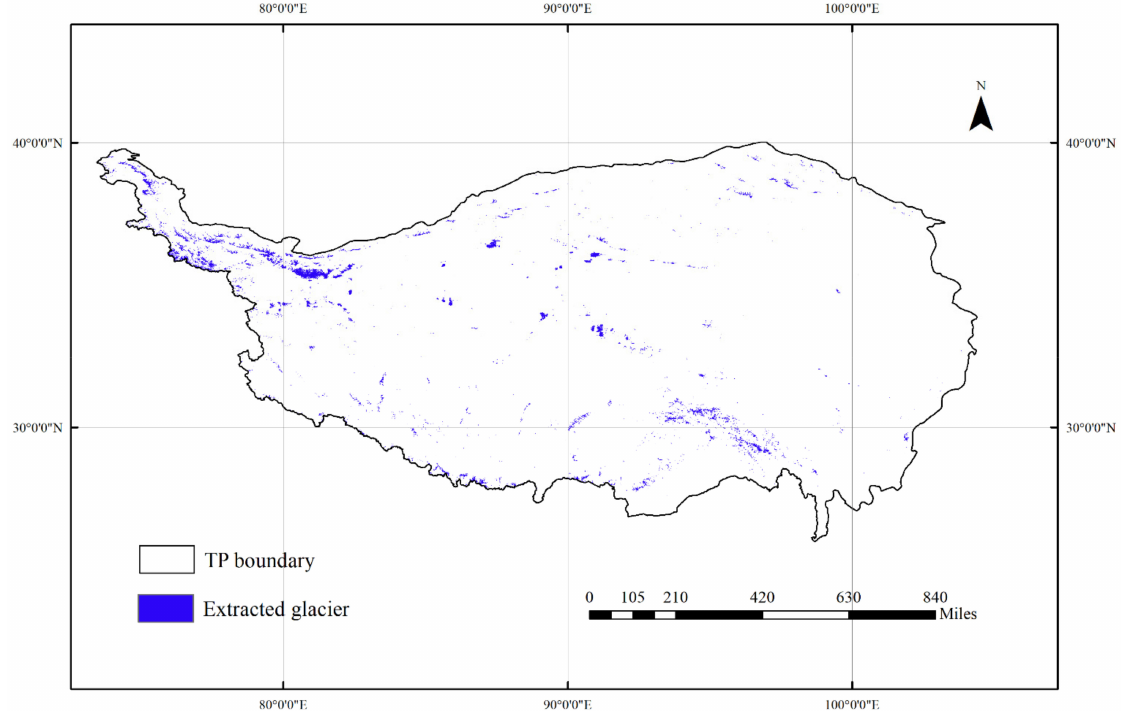
Figure 9. Overall glacier extraction results on the Tibetan